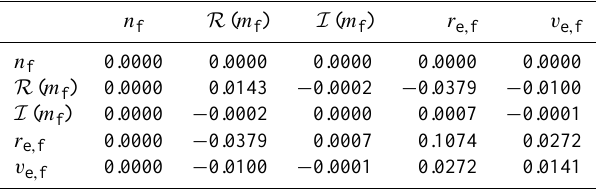
Table 6. Error components for fine mode optical thickness at 532nm for the segment 170 retrieval with HSRL data and solar zenith angle error assessed at 0.5 ◦ . These are the elements within the summations in Eq.